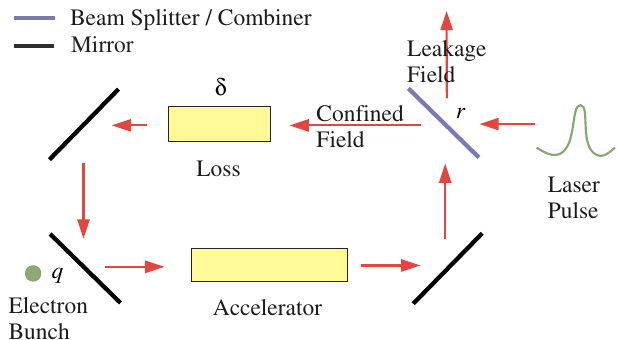
FIG. 1. (Color) The intracavity coupled, laser-driven linear ac- celerator pumped by the external